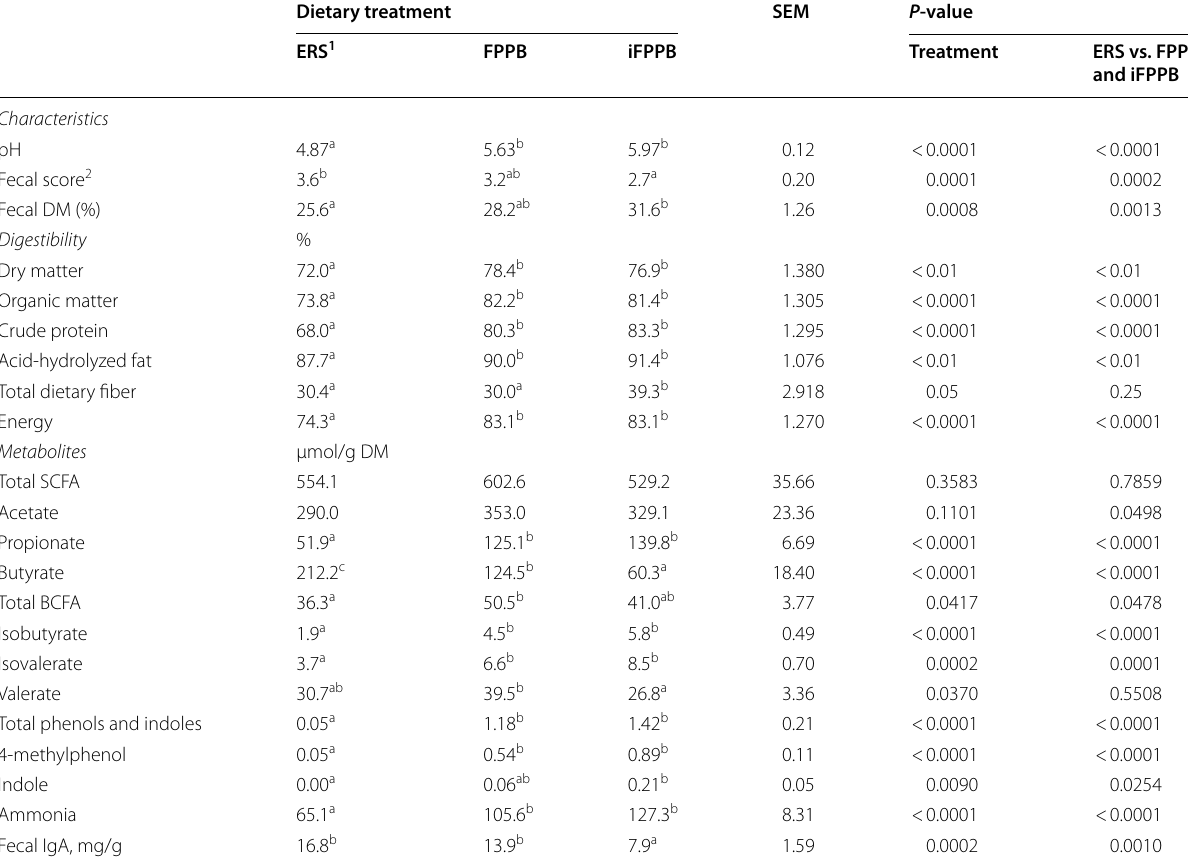
Table 1 Feline fecal characteristics and metabolite concentrations and apparent total tract nutrient digestibility of experimental